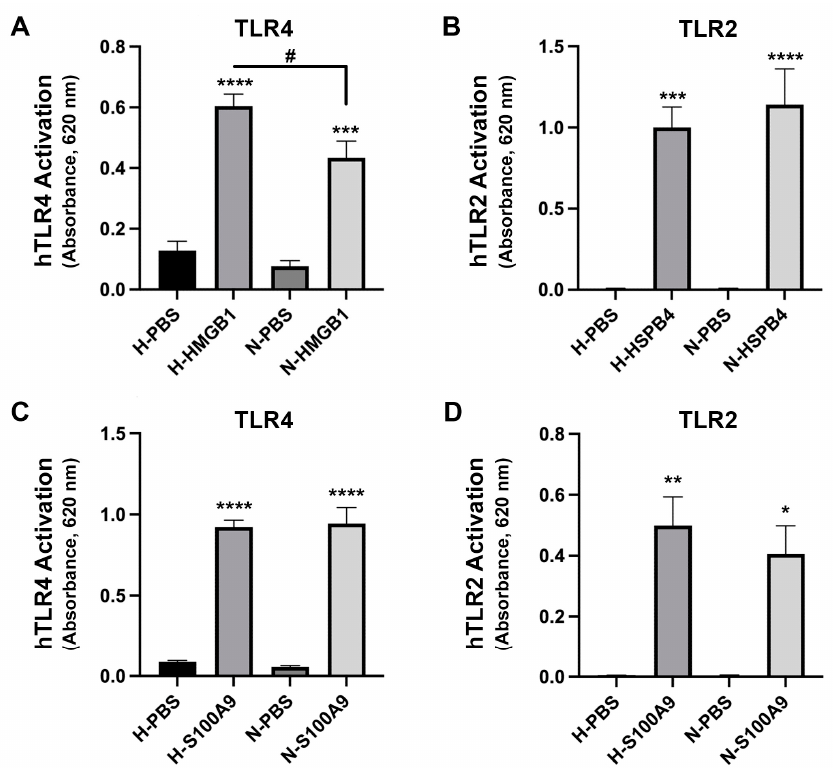
Figure 6. TLR4 activation by HMGB1, but not S100A9, increased in the presence of high glucose, but TLR2 activation by HSPB4 and S100A9 was unaffected. TLR activity was measured as a change in absorbance at 620 nm. Results represent the means ± standard error of the mean for four separate experiments. ( A ) HEK-Blue-hTLR4 cells were incubated with or without 20 µg/mL HMGB1 in growth medium containing either 1 g/L (Normal, N-) or 4.5 g/L (High, H-) glucose. Activation of TLR4 by HMGB1 was enhanced in high glucose. ( B ) HEK-Blue-hTLR2 cells were incubated with or without HSPB4 in growth medium containing either 1 g/L (Normal, N-) or 4.5 g/L (High, H-) glucose. hTLR2 activation was not significantly different between the two groups. ( C , D ) HEK-Blue-TLR4 ( C ) or HEK-Blue-TLR2 ( D ) cells were incubated with or without 10 µg/mL S100A9 in growth medium containing either 1 g/L (Normal, N-) or 4.5 g/L (High, H-) glucose. Activity of both TLR4 and TLR2 in response to S100A9 was equivalent in H- and N-glucose media. * p < 0.05, ** p < 0.01, *** p < 0.001, **** p < 0.0005 versus H- or N-PBS control; # p < 0.05 as indicated, using ANOVA with Tukey’s post-hoc testing. hTLR4, human toll like receptor 4; HMGB1, high mobility group box 1; HSPB4, heat shock protein B4; N-, normal glucose (1 g/L); H-, high glucose (4.5 g/L); hTLR2, human toll-like receptor 2; S100A9, S100 calcium binding protein A9.